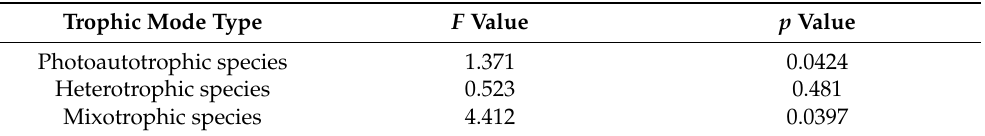
Table 2. Results of one-way analysis of variance to assess the relationship of species abundance of different groups with sampling months (April, May, and